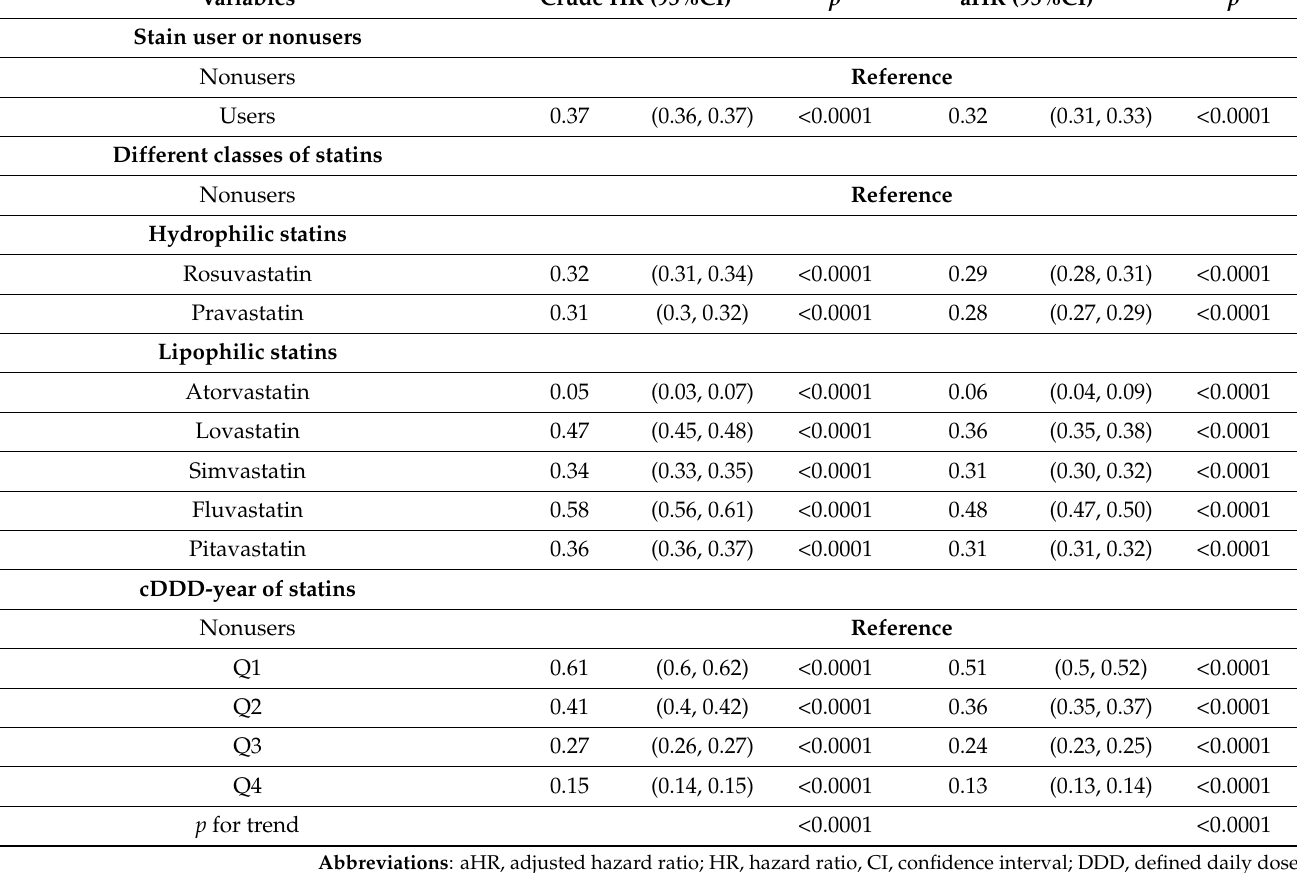
Table 2. All-cause mortality and aHRs for statin use in patients with type 2 diabetes.